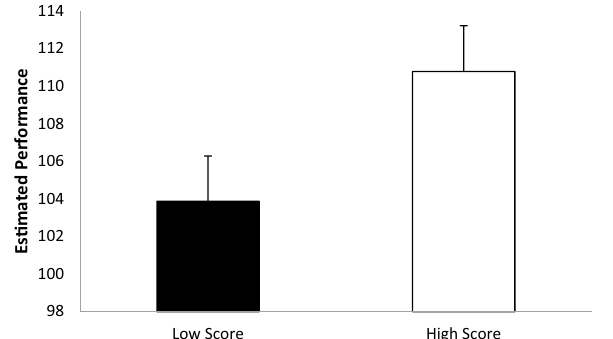
Figure 1. Participants mean score ratings as a function of actual performance (error bars represent standard